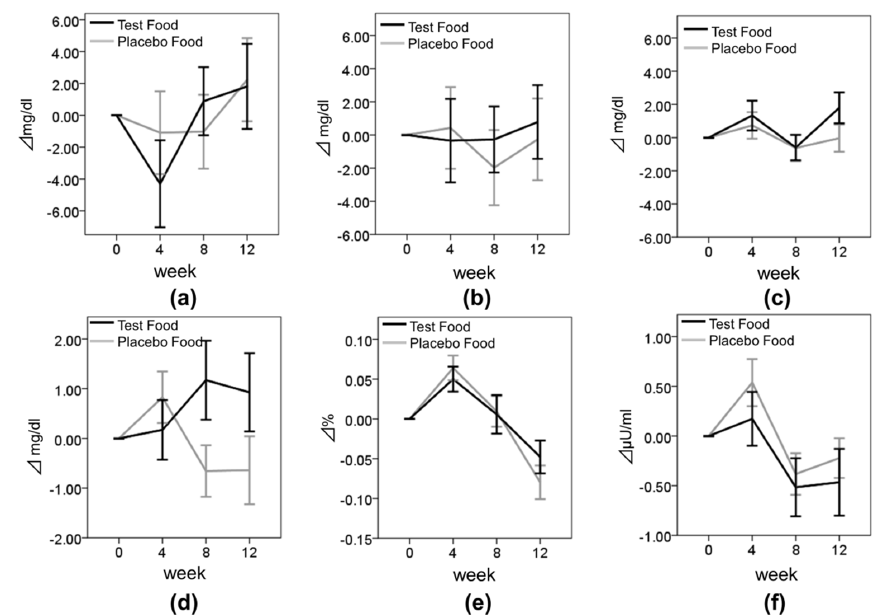
Figure 4. Changes in the lipid metabolism and blood glucose parameters. Values are means ± SE. ( a ) TC; ( b ) LDL ‐ C; ( c ) HDL ‐ C; ( d ) FPG; ( e ) HbA1c; and ( f ) Insulin. Black bar, test group; Gray bar, placebo group.